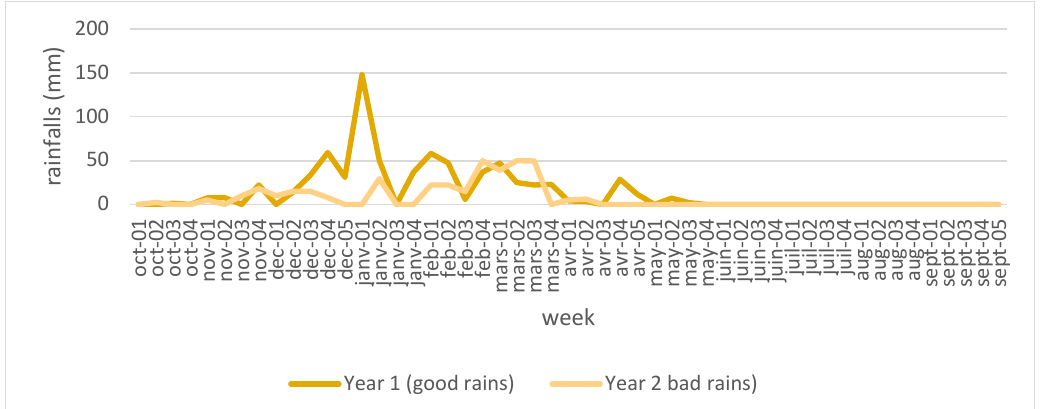
Figure 7. Weekly rainfall data. The figure shows the two sets of data used for the rain